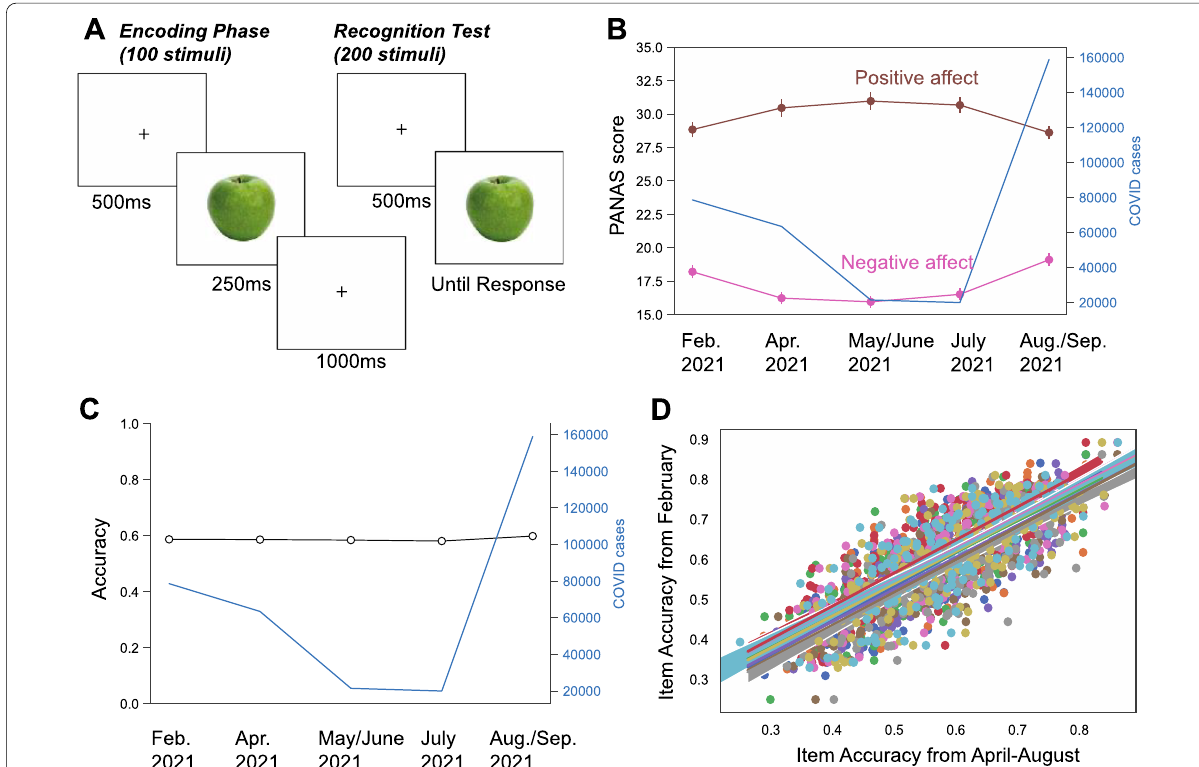
Fig. 1 Visual recognition memory was highly stable despite large changes in pandemic state and perceived emotional states. A Adult participants (200 in each data collection, 1000 total) were asked to remember 100 pictures, with 5 exemplars from 20 semantic categories. Each picture was shown for 250 ms during the encoding phase. They were later tested by recognizing the studied pictures from a stream of 200 pictures, consisting of all 100 studied pictures and 100 new pictures with the same number of exemplars from the same semantic categories. B COVID-19 case numbers influence on subject’s self-reported positive and negative affect. C Recognition memory performance (proportion correct) did not change with respect to the time of data collection, even as COVID-19 cases in the US varied drastically. The mean, variance, and skewness of the d-prime index of memory sensitivity were also statistically unchanged across the five data collections (see Additional file 1: Fig. S1). D Pairwise correlations between February recognition accuracy of each item and recognition from each other data collection